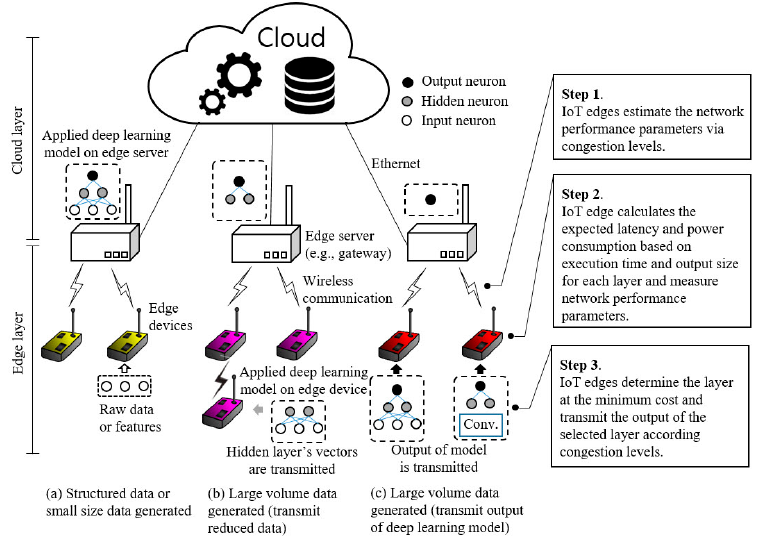
Figure 1. Offload and transmission strategy overview based on generated data size and computation performance considering media channel condition on IoT edge device with deep learning model.